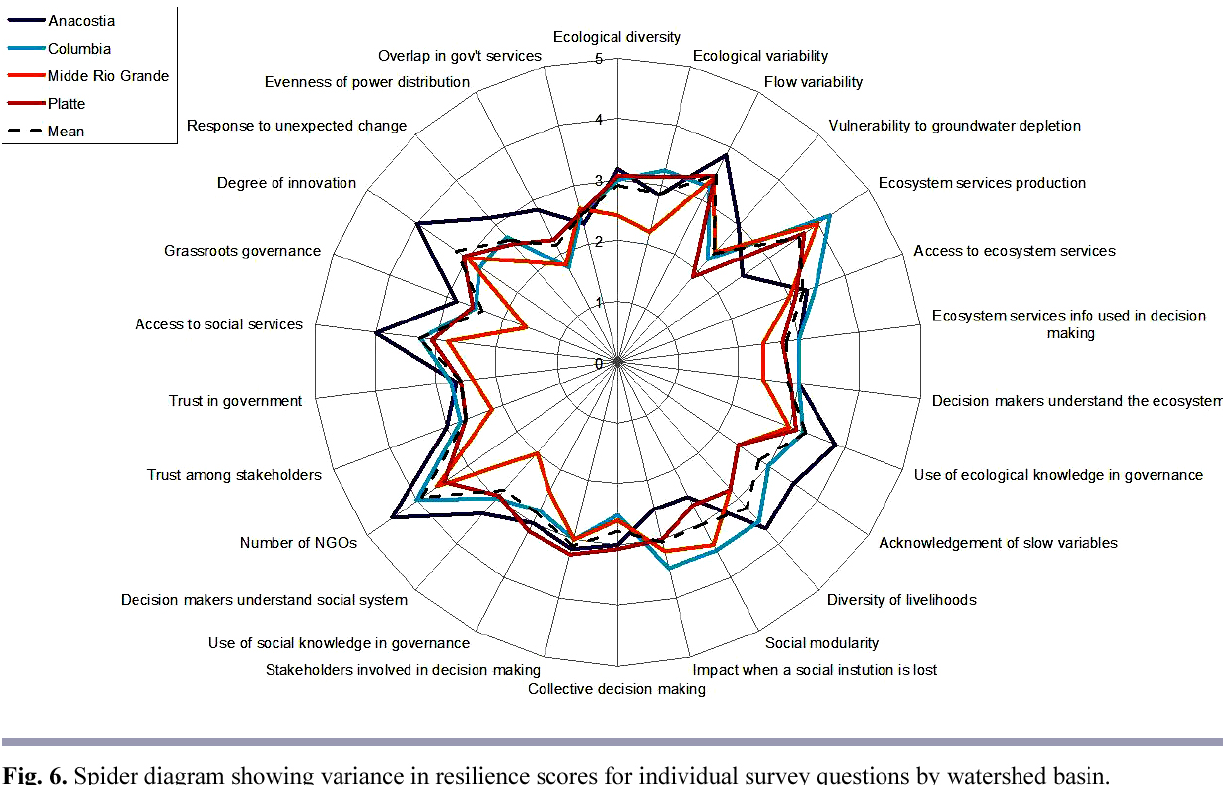
Fig. 5 . Spider diagram showing average resilience scores for individual survey questions by watershed